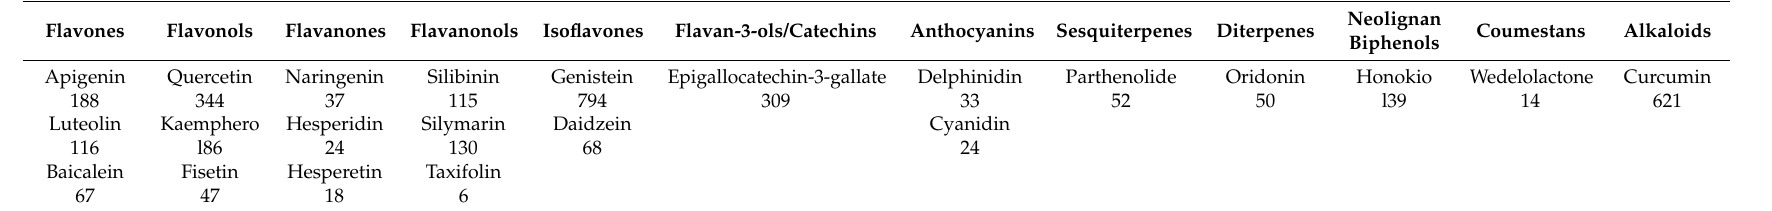
Table 1. Classification of flavonoids and other polyphenolic